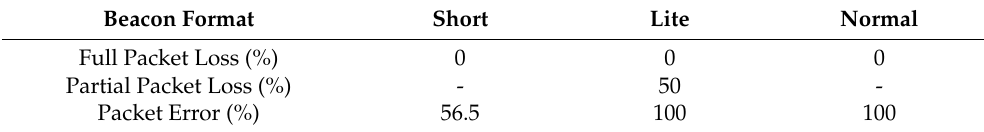
Table 9. 40 km end-to-end test result.